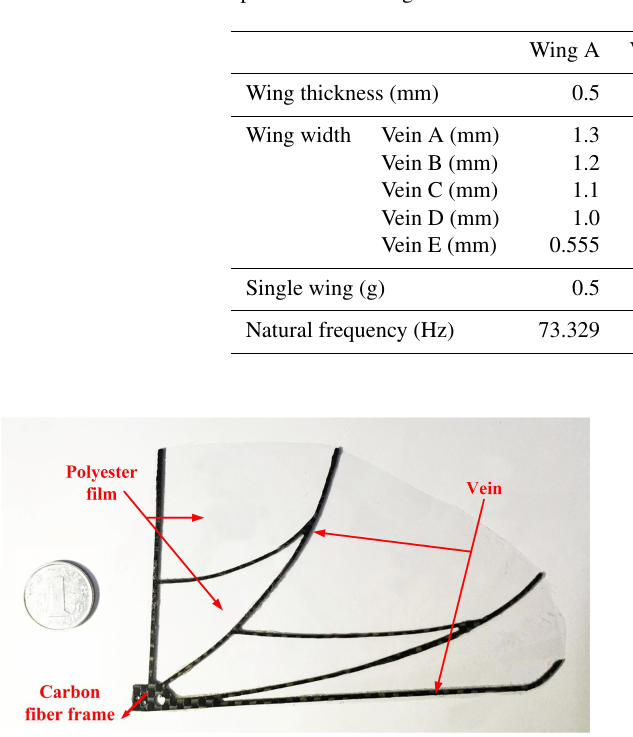
Table 4. The different size parameters of wing stiffness.